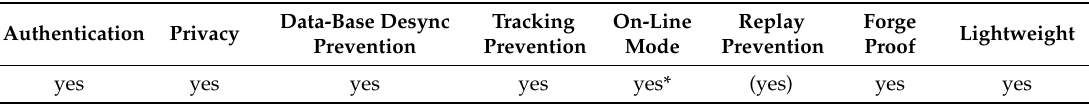
Table 1. Summary of security related properties of the new solution (*on-line mode depends on reader’s real-time access to a back end